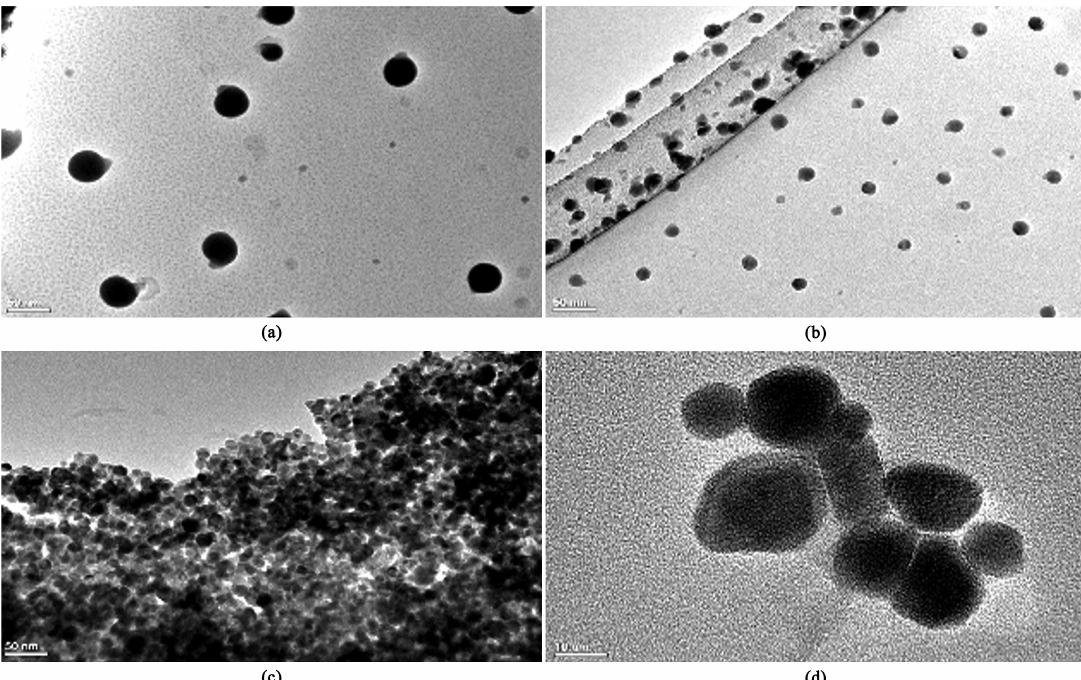
Figure 4. TEM micrographs of the as-synthesized In Un-irradiated AcAc and SDS; d) γ-irradiated AcAc (10 2 kGy) and